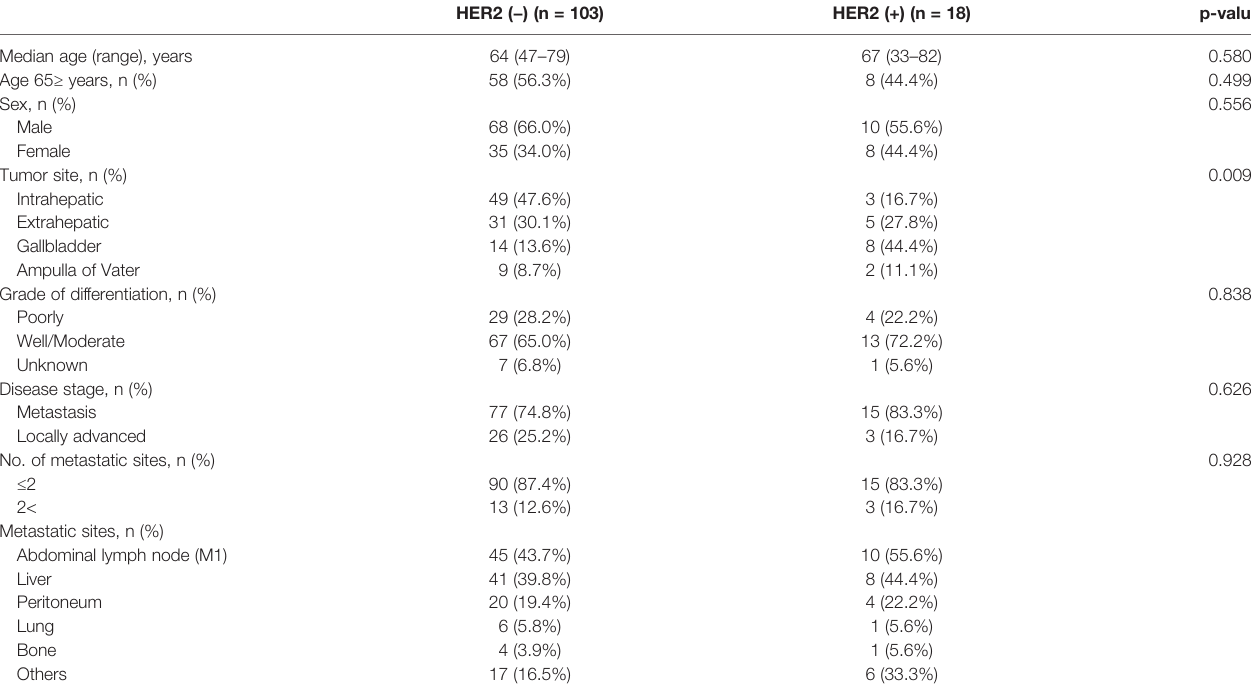
TABLE 1 | Baseline patient